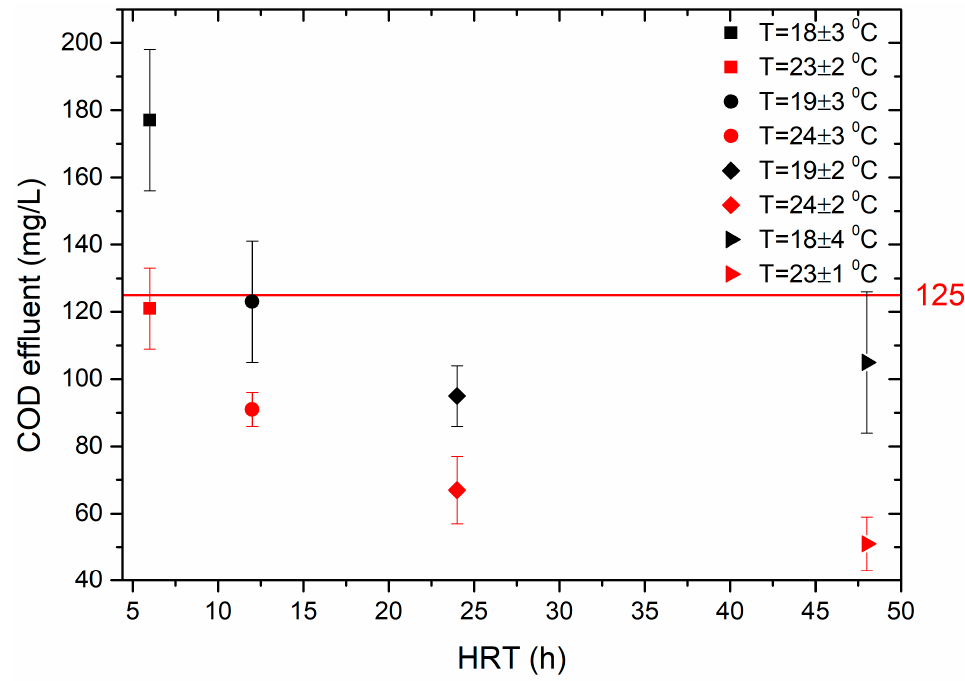
Figure 7. COD e ffl uent values for four HRTs examined. Figure 7. COD effluent values for four HRTs